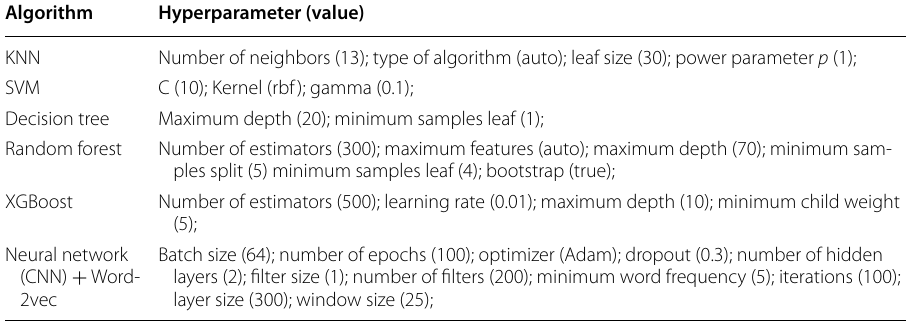
Table 1 Hyperparameter settings